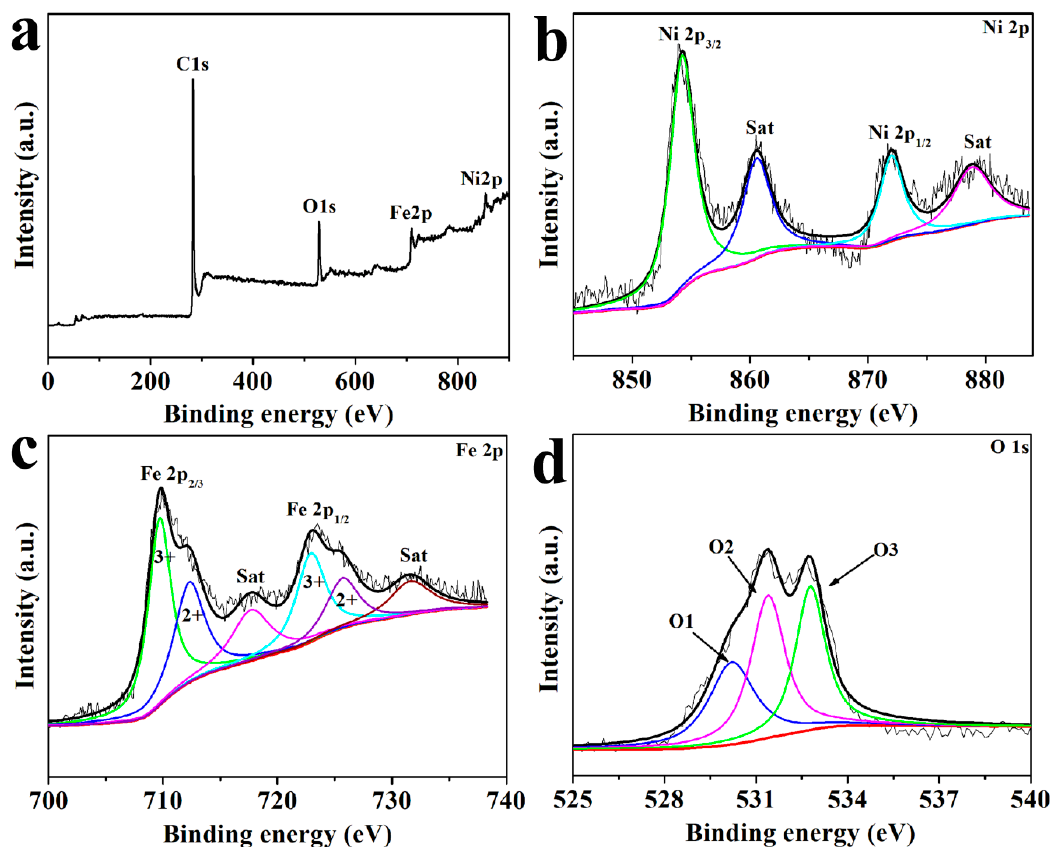
Figure 6. XPS spectra of ( a ) survey scan, ( b ) Ni, ( c ) Fe, and ( d ) O for NFO-YS@C.